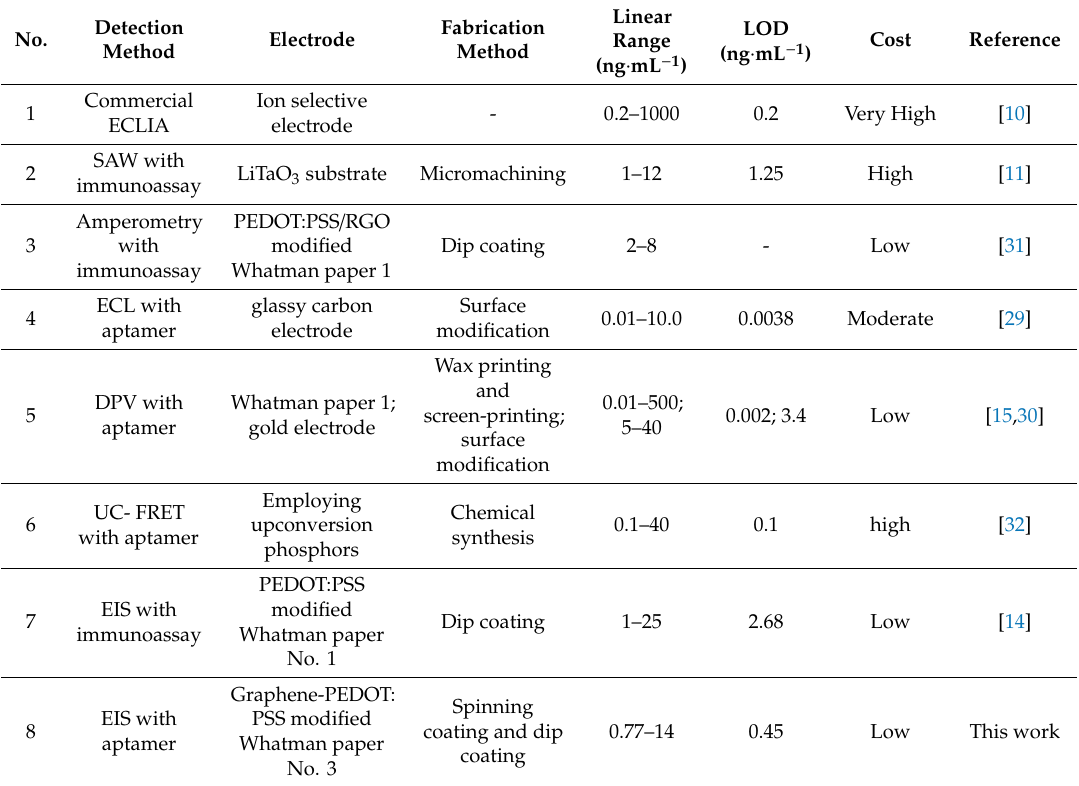
Table 2. Comparisons of reported biosensors and their sensing characteristics towards CEA.